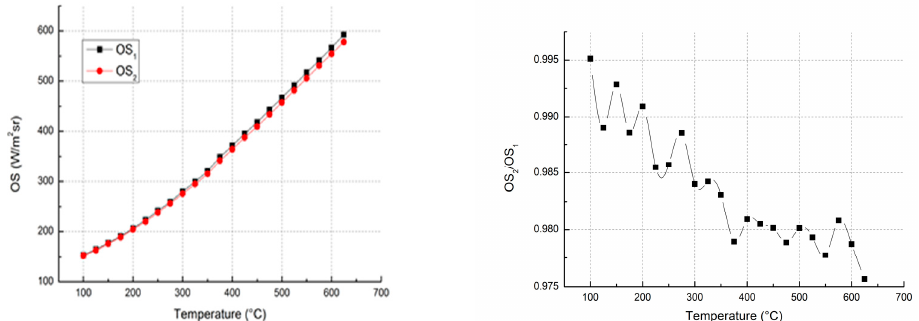
Figure 1. ( Left )—the experimental object signal (OS); OS1 = BP-10400-737, OS2 = BP-10500-775, respectively, with the center at 10.454 µ m and 10.464 µ m; trends versus temperature. ( Right )—the experimental SR = OS2/OS1 curve [6].